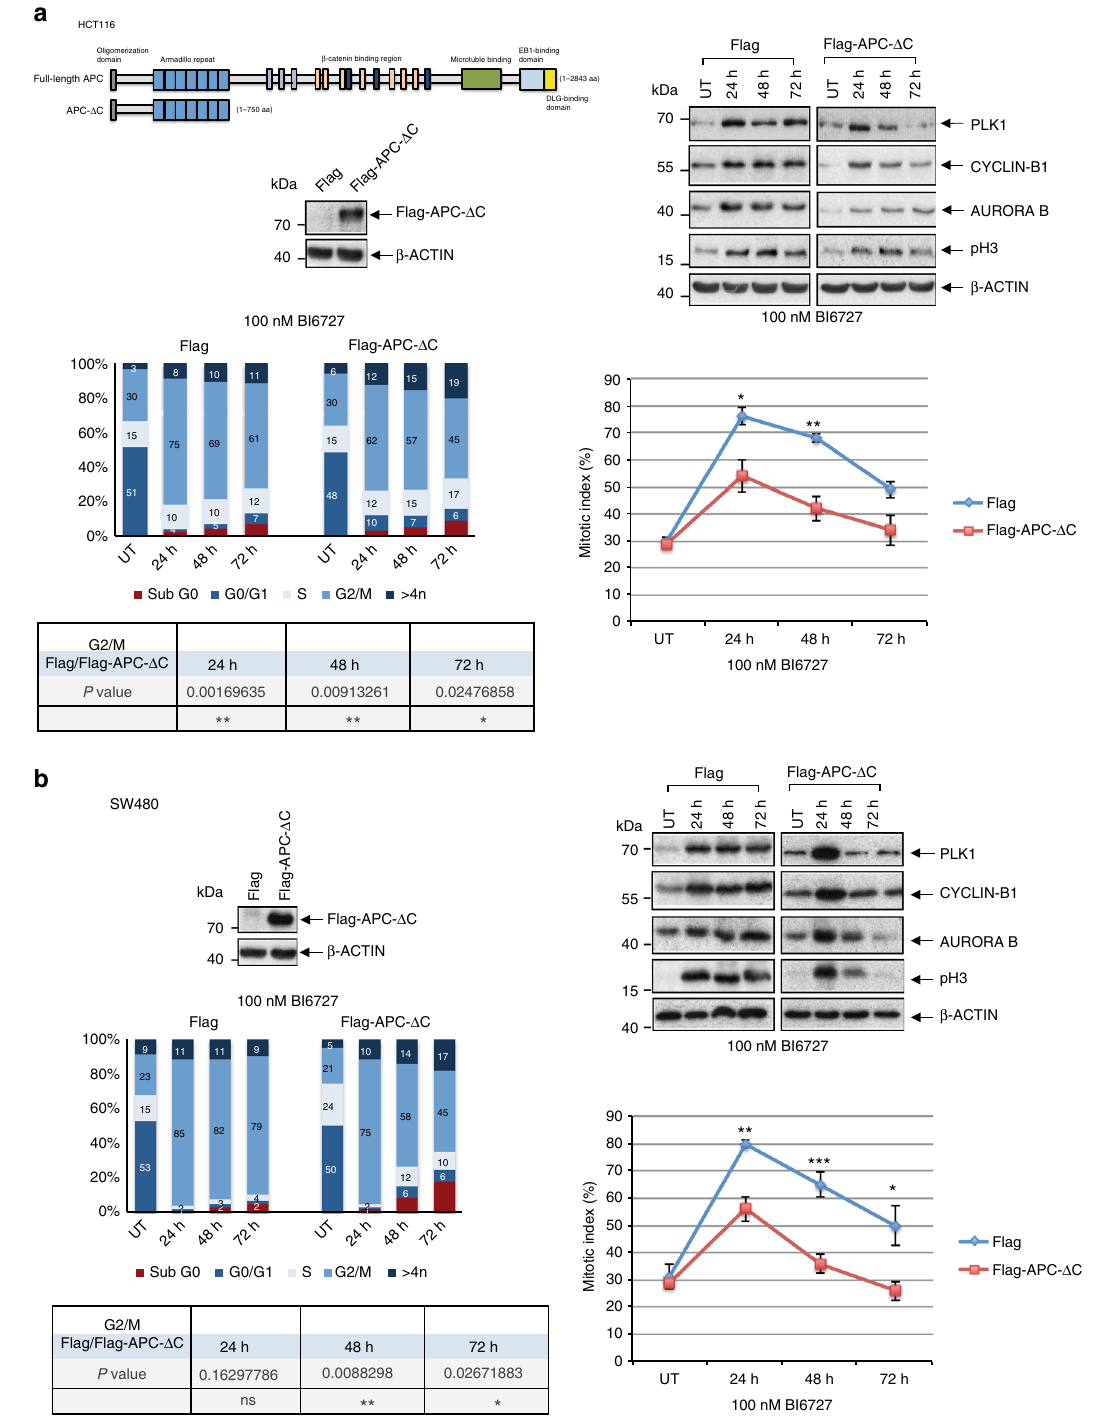
Fig. 1 Correlation of PLK1 inhibition and mitotic arrest in APC- Δ C-expressing colon cells. (Upper left) Schematic representation of full-length APC and the truncated form APC- Δ C. Protein extracts from transfected colon cancer cell lines ( a ) HCT116 and ( b ) SW480 were blotted to detect Flag-tagged proteins. (Upper right) Cells were treated with 100 nM BI6727 followed by immunoblotting for PLK1, Cyclin B1, Aurora B, phosho-Histone H3 (pH3), and β -Actin. (Lower left) For the analysis of the cell cycle stage distribution of treated cells propidiumiodide was added to lysates which binds stoichiometrically to nucleic acids. After RNase-treatment and eliminating doublets or clumps the DNA-histogram determined by FACS gives information about the cell cycle. The representative quanti fi cation of the cell cycle analysis by FACS showing control (UT, untreated) and APC- Δ C-expressing cells treated for 24, 48, and 72 h with 100 nM BI6727; statistical evaluation of the percentages of cells in G 2 /M comparing APC- Δ C-expressing and control cells at 24, 48, and 72 h. (Lower right) The mitotic indices of cells treated with 100 nM BI6727 for 24, 48, and 72 h is depicted (means ± s.d., n = 3, for each concentration). * P < 0.05, ** P < 0.01, *** P < 0.001, Student ’ s t -test, unpaired and